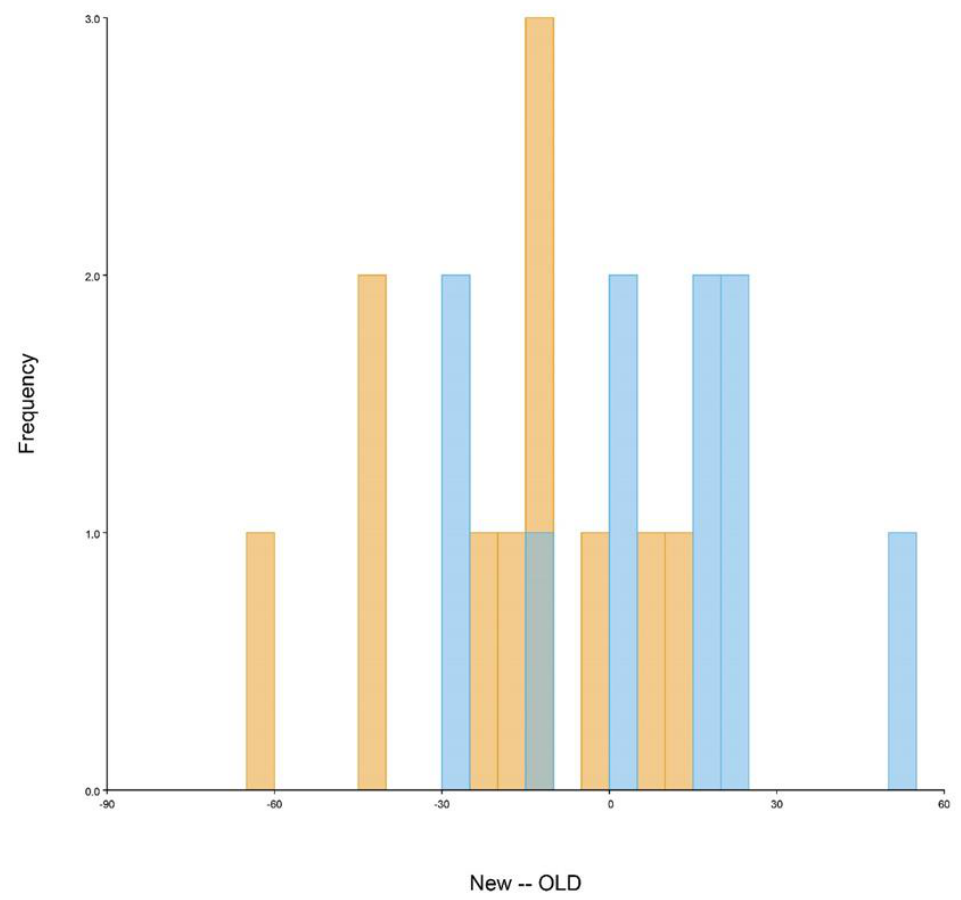
Figure A3. Discriminant analysis of brain shape variation for the New and Old spider groups. Discriminant scores (frequencies) after a “leave-one-out” cross-validation are shown using histogram bars with the default 24 bins. Overlap between both groups of specimens and p = 0.7229 suggest no significant shape difference between the groups. Fresh material ( New ) is marked in dark yellow and legacy material ( Old ) in blue.